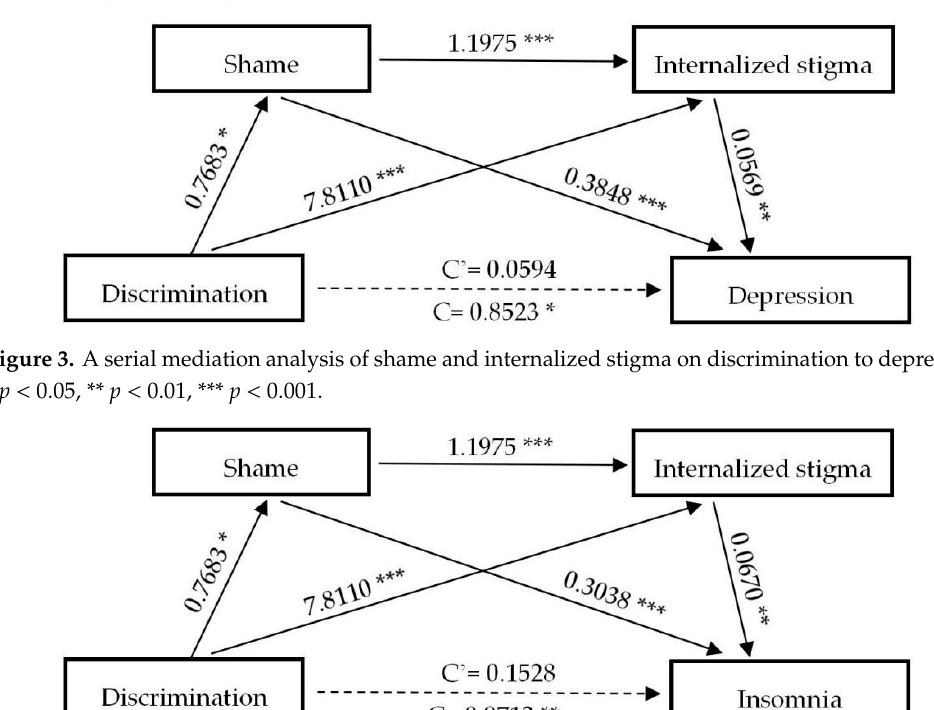
Figure 2. A serial mediation analysis of shame and internalized stigma on discrimination to distress. * p < 0.05, ** p < 0.01, *** p < 0.001.